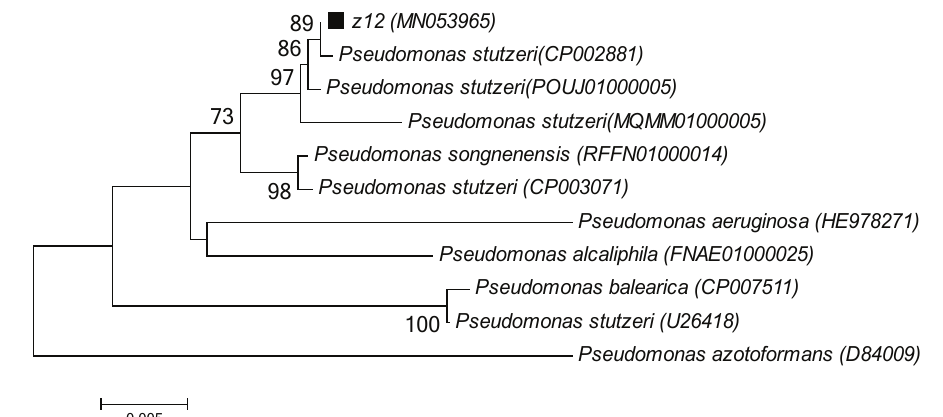
Fig. 1 GC-MS analysis of oily sludge contaminated soil